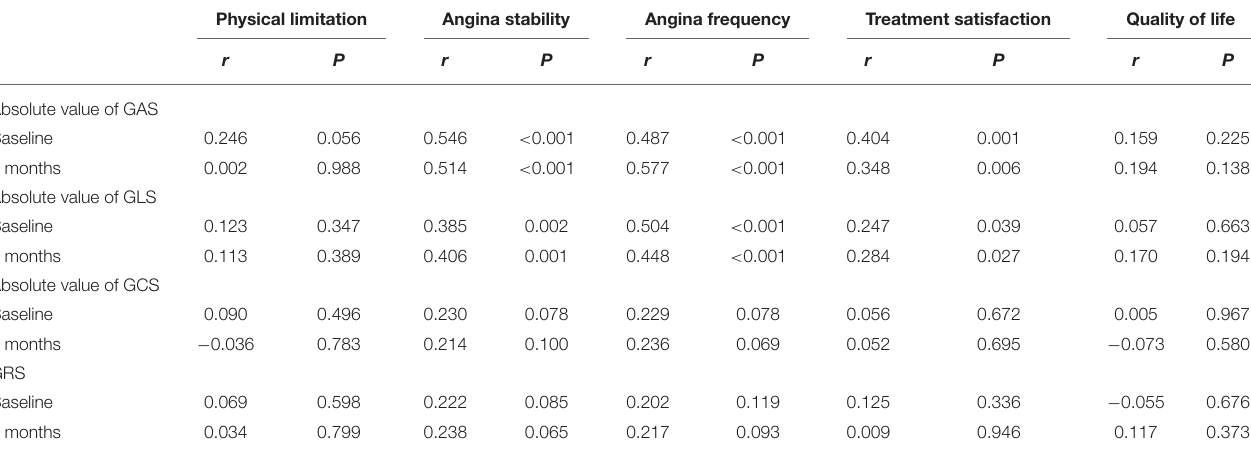
TABLE 6 | Relationship of strain parameters with seattle angina questionnaire